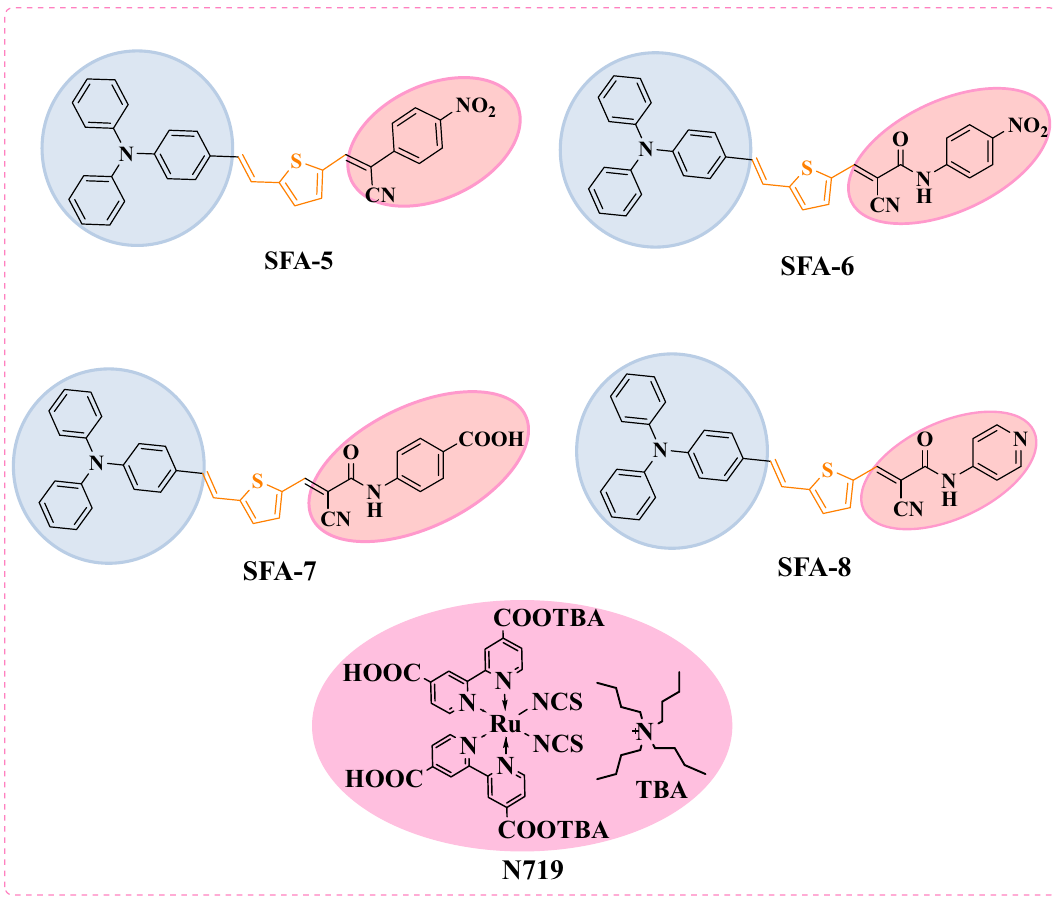
Figure 1. Molecular structures of sensitizers SFA-5–8 and